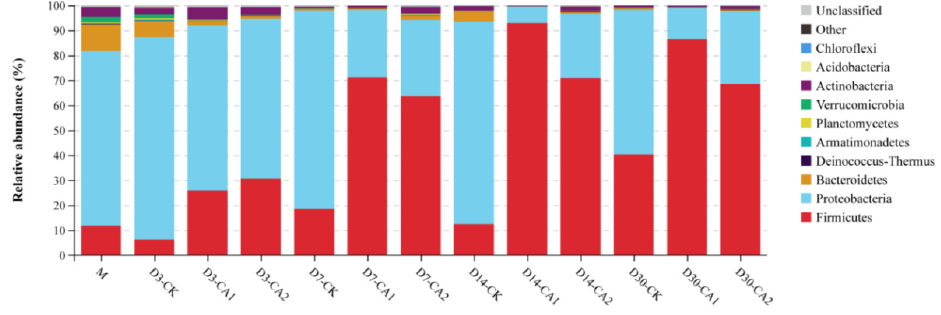
Figure 3. Bacterial community and relative abundance by phylum for mulberry leaf silages (M, pre- ensiled material; CK, the control; CA1, 1% citric acid; CA2, 2% citric acid; D3, 3 days of ensiling; D7, 7 days of ensiling; D14, 14 days of ensiling; D30, 30 days of ensiling).